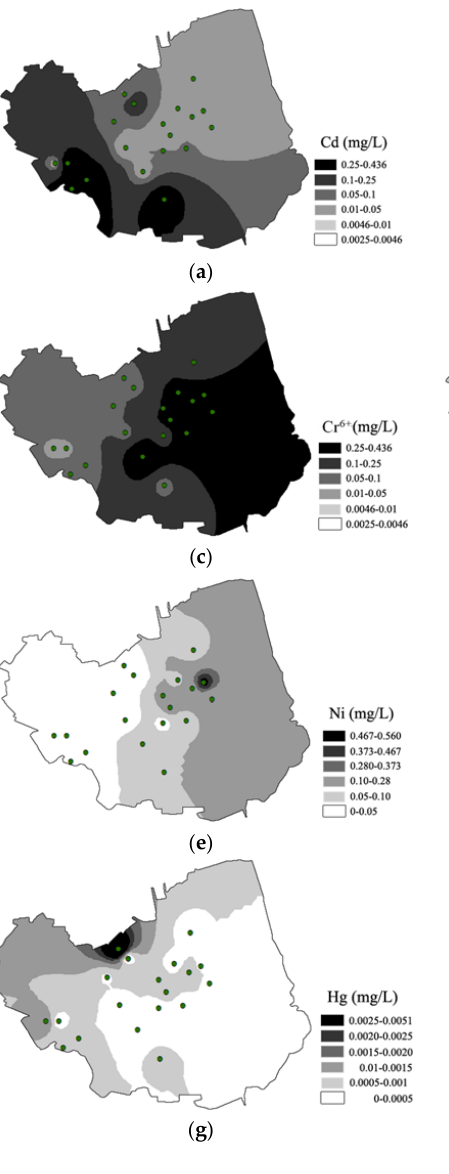
Figure 2. Spatial distribution of Cd ( a ); Cr ( b ); Cr 6+ ( c ); Pb ( d ); Ni ( e ); Zn ( f ); Hg ( g ) and Cu ( h ) in the groundwater of the brownfield.